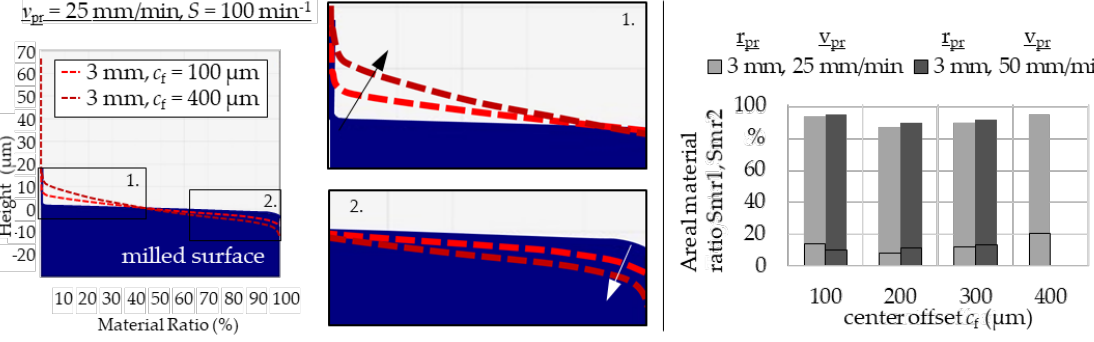
Figure 14. Comparison of Abbott curves generated by milling and pulsed mechanical surface treatment.